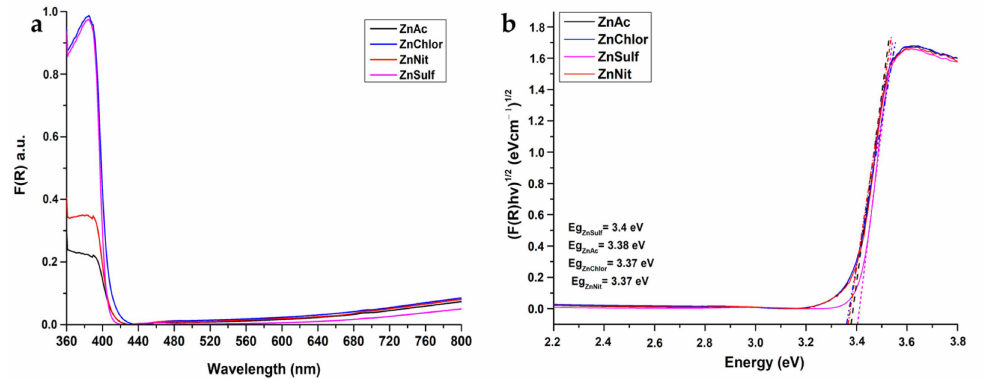
Figure 7. ( a ) F(R) reflectance as a function of the wavelength for the ZnO nanoparticles, structured from all four precursors (zinc acetate dehydrate (ZnAc), zinc nitrate hexahydrate (ZnNit), zinc chloride (ZnChlor), zinc sulphate heptahydrate (ZnSulf)). ( b ) Energy band gap of the same